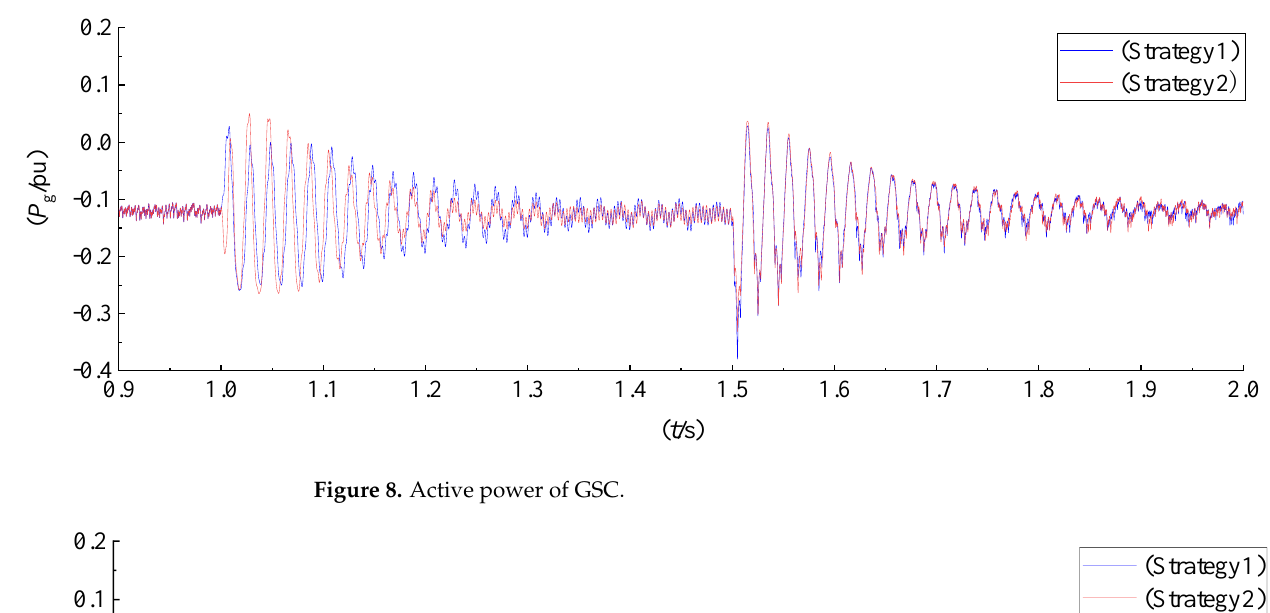
Figure 8. Active power of GSC.